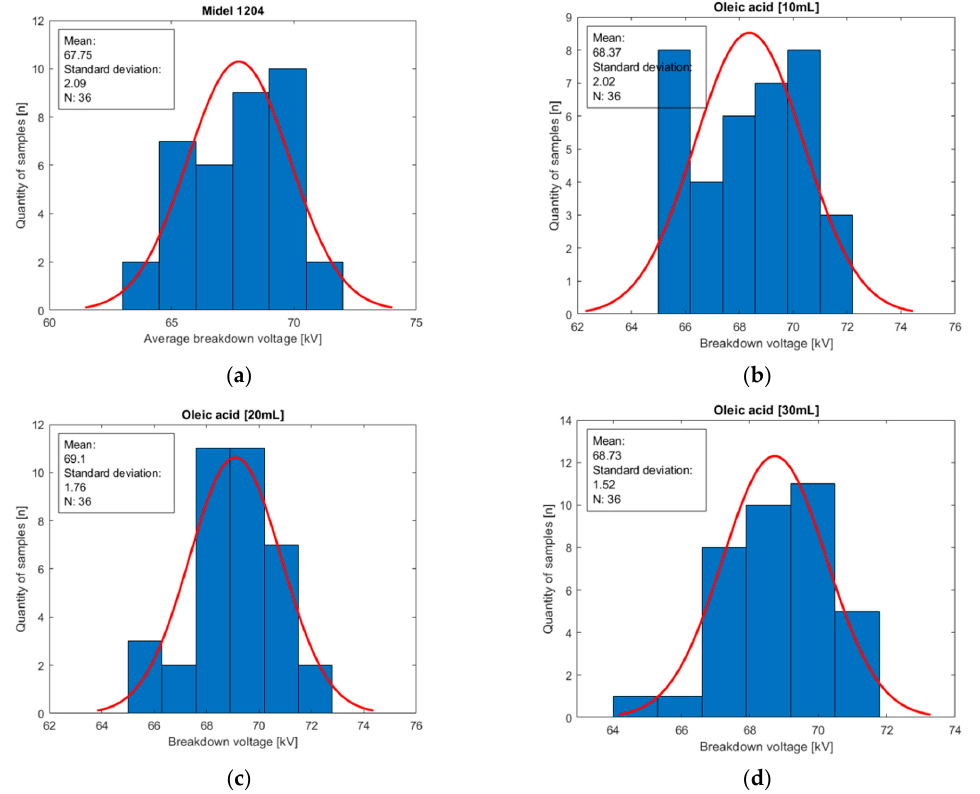
Figure 11. Histograms of oil population Midel 1204 with different concentrations of surfactant oleic acid: ( a ) base sample of Midel 1204; ( b ) 10 mL of surfactant oleic acid in a sample; ( c ) 20 mL of surfactant oleic acid in a sample; ( d ) 30 mL of surfactant oleic acid in a sample.